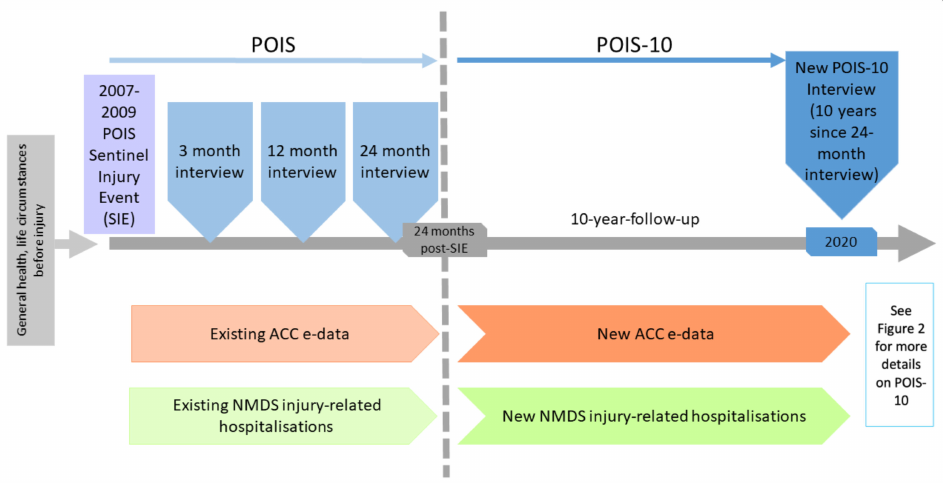
Figure 1. Overview of POIS-10 in relation to the earlier POIS